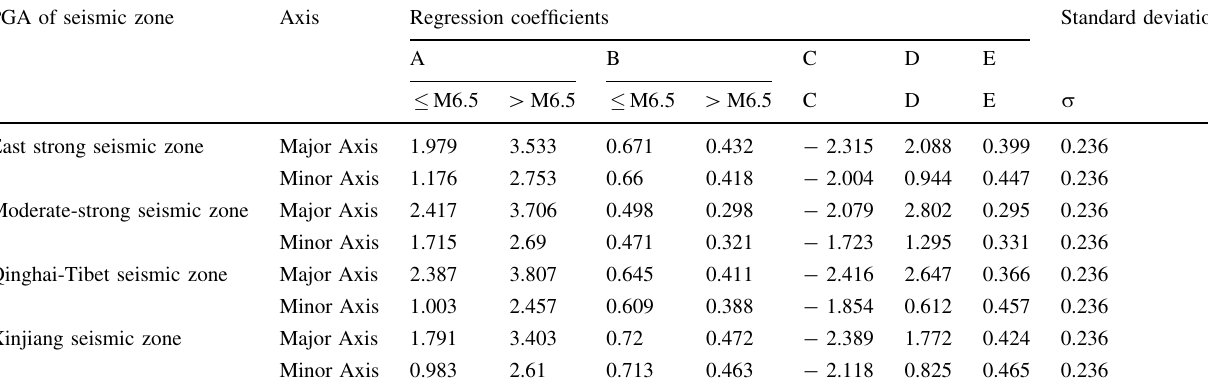
Table 3 Parameters of the peak ground acceleration of seismic zones PGA of seismic